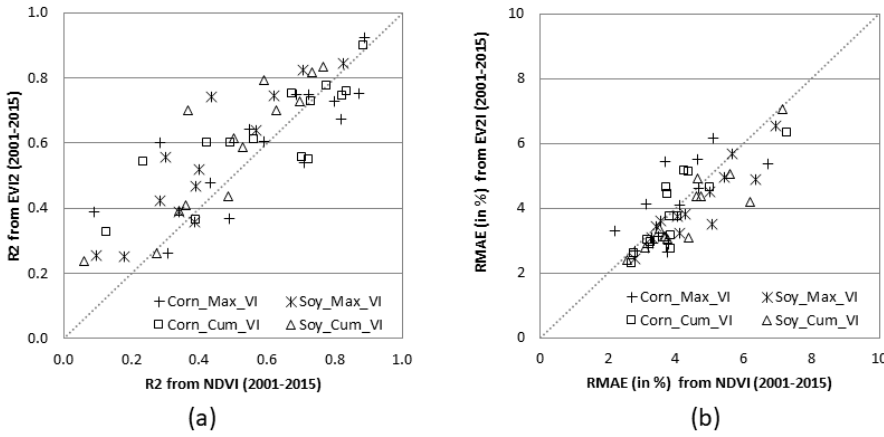
Figure 8. Comparison of R 2 ( a ) and the relative mean absolute errors (RMAE) ( b ) between yield and VIs ( x -axis: with NDVI; y -axis: with EVI2). Each symbol shows the statistics from one year (2001–2015) generated from 20 counties. Two VI metrics include cumulative VI (Cum_VI) and maximum VI (Max_VI). EVI2 shows higher R 2 (above the 1:1 line) and lower RMAE (below the 1:1 line) than NDVI. Statistics that are not significant ( p -value < 0.05) from both NDVI and EVI2 are excluded. The relative MAEs for NDVI and EVI2 metrics (maximum, small and large cumulative) for both